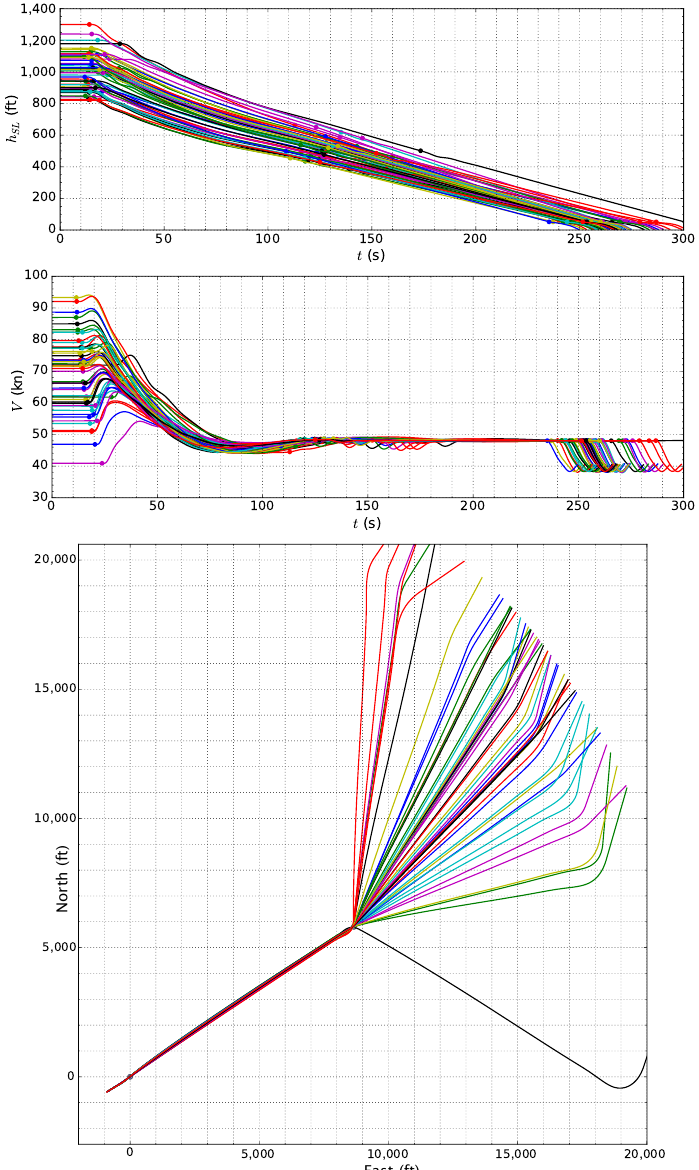
Figure 3. Time histories of altitude above Mean Sea Level ( Top ) and of velocity magnitude ( Middle ) for a set of 50 flight simulations. Although starting with random initial conditions, all aircraft arrive at the landing field with a final altitude of exactly 50ft (i.e., the prescribed obstacle height) and the same prescribed speed; ( Bottom ) ground tracks for the same set of 50 flight simulations. Despite the random intial position, all aircraft correctly pass through the alignment checkpoint and land at (0,0)